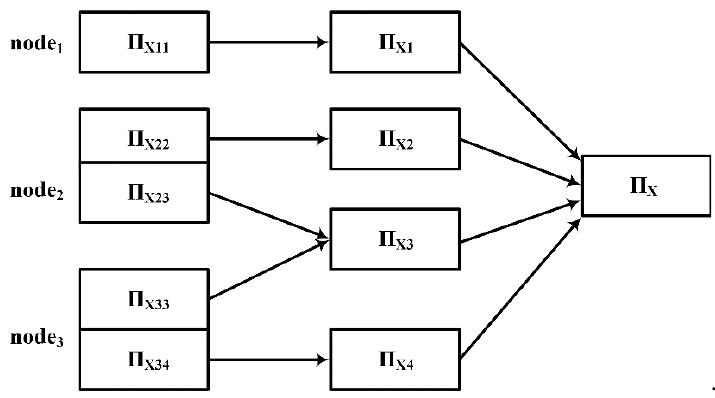
Figure 6. The process of merging the local equivalence classes of each node.